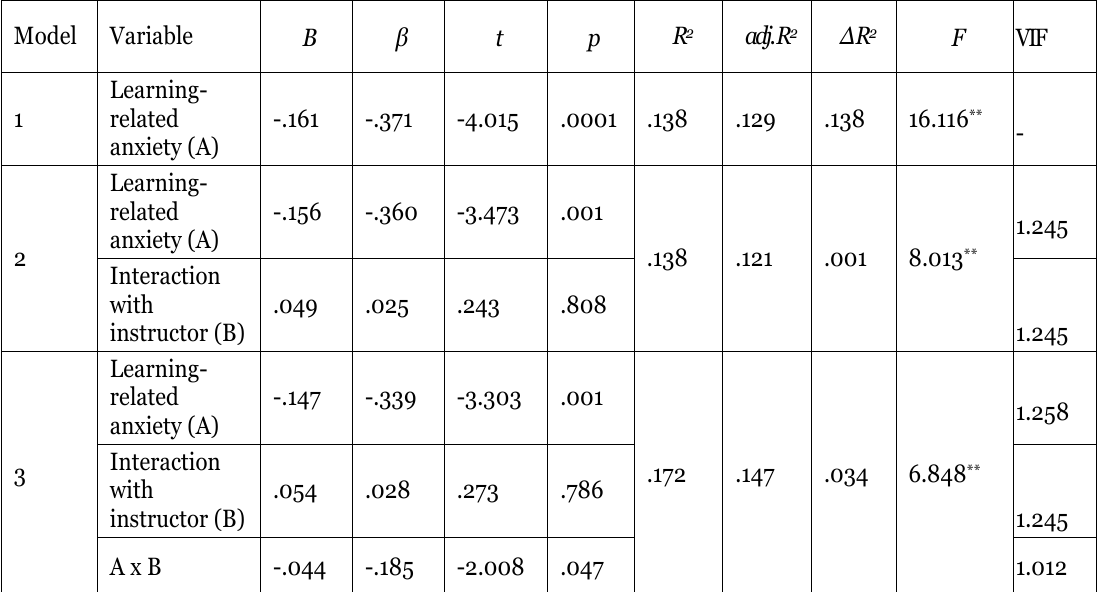
A Test of Buffering Effect of Interaction with Instructor on the Relationship of Learning-Related Anxiety and Intention to Persist. (n=103)